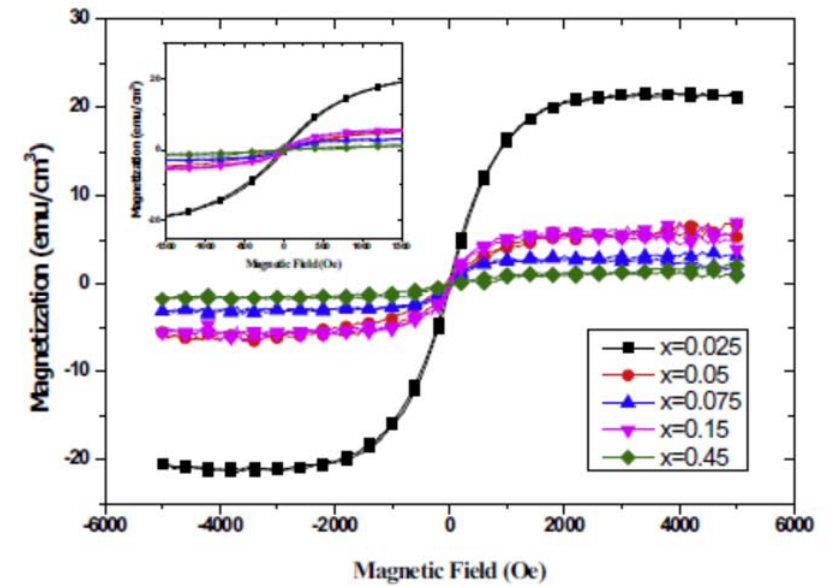
Figure 14. M vs. H hysteresis loop for In 2 O 3 films with different composition of Fe (x = 0.025–0.45). Inset shows the magnified view of low field curve (The Figure is reproduced with copyright permission [105]).